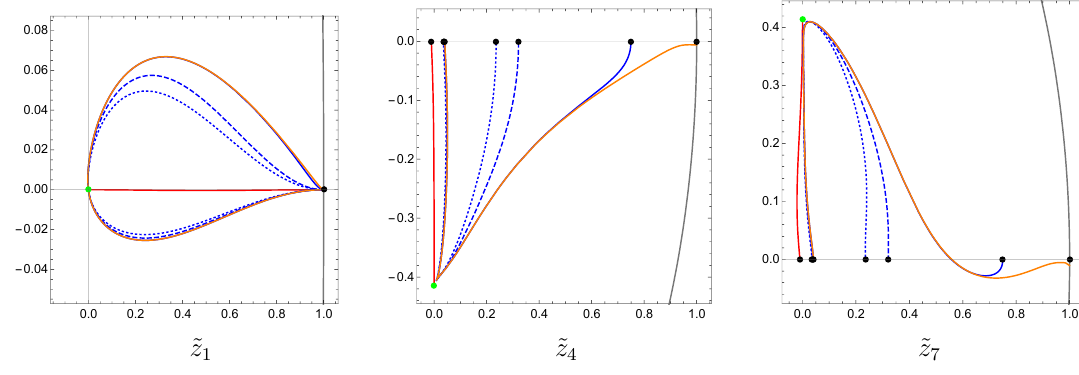
Figure 9 . Samples of regular flows within the SO(3) -invariant sector using the boundary condi- tions (3.35) for the complex scalar fields ˜ z AdS 4 vacuum and the D3-brane asymptotics are denoted by green and black dots, respectively. The grey line in the left plot corresponds to the boundary values | ˜ z to the choice (cid:15) ≈ 0 whereas the orange one corresponds to (cid:15) ≈ (cid:15) right plots are compatible with SO(6) invariance, i.e. ˜ z